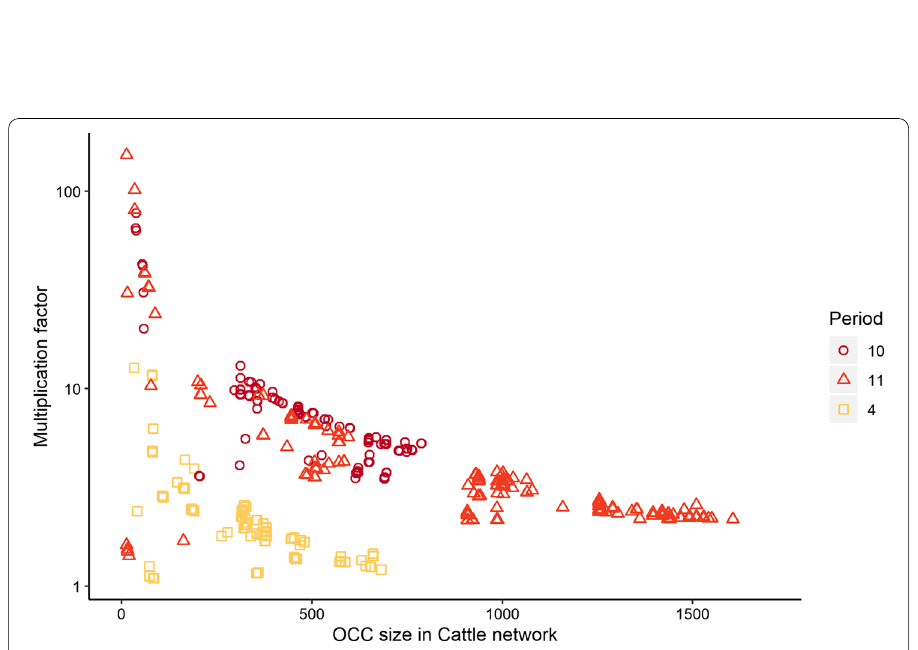
Fig. 9 Multiplication factor of cattle premises in the multi‑species network for three periods of the year. The graph shows the multiplication factor in log scale according to the OCC in the cattle network. Only premises with an OCC of at least ten premises are